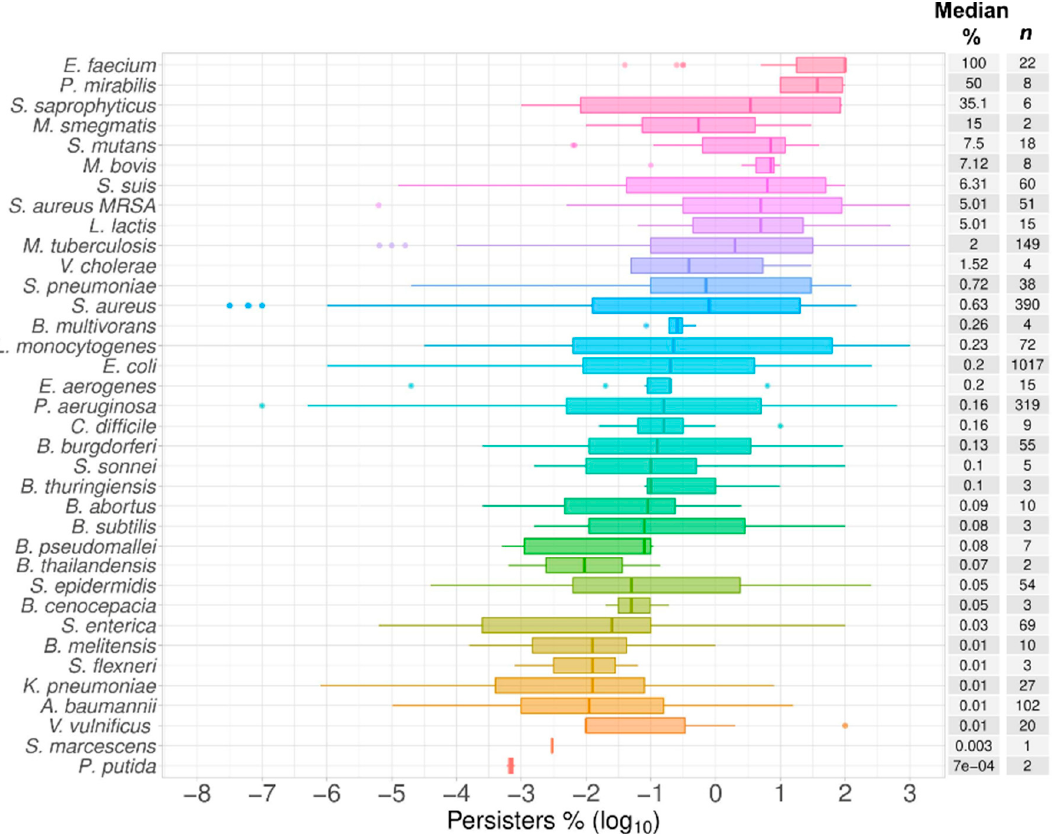
Figure 2. Bacterial species. A total of 36 bacterial species were listed in the order of the median value as plotted as box plots of the percentage of cells surviving the exposure to antibiotics in comparison to time zero in time–kill assays, or in comparison to the control without antibiotics in one-time-point experiments. The abscissa represents the spread of the data as log 10 values of the percentage of persisters. The median value for the percentage of surviving cells is listed in the median % column followed the total number of time points collected for each species ( n ).